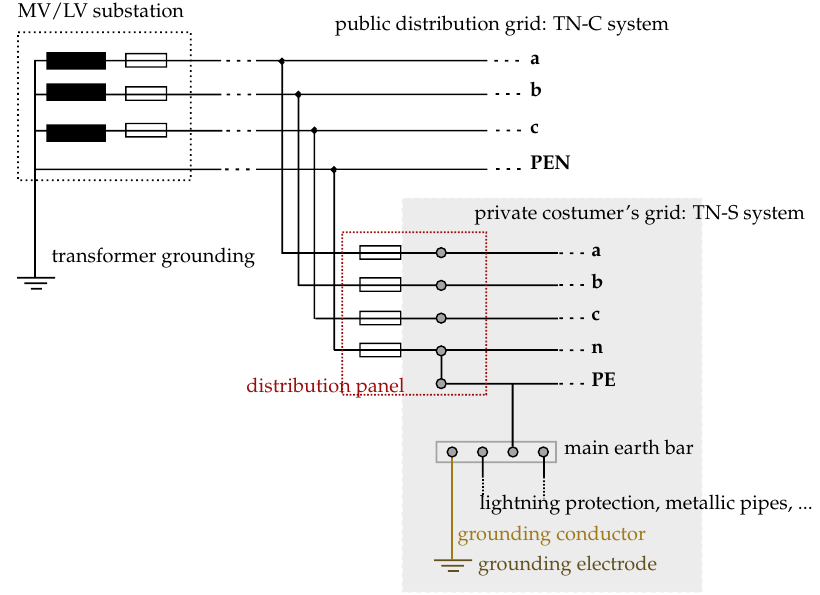
Figure 5. TN-C-S system, based on Reference [1,10].